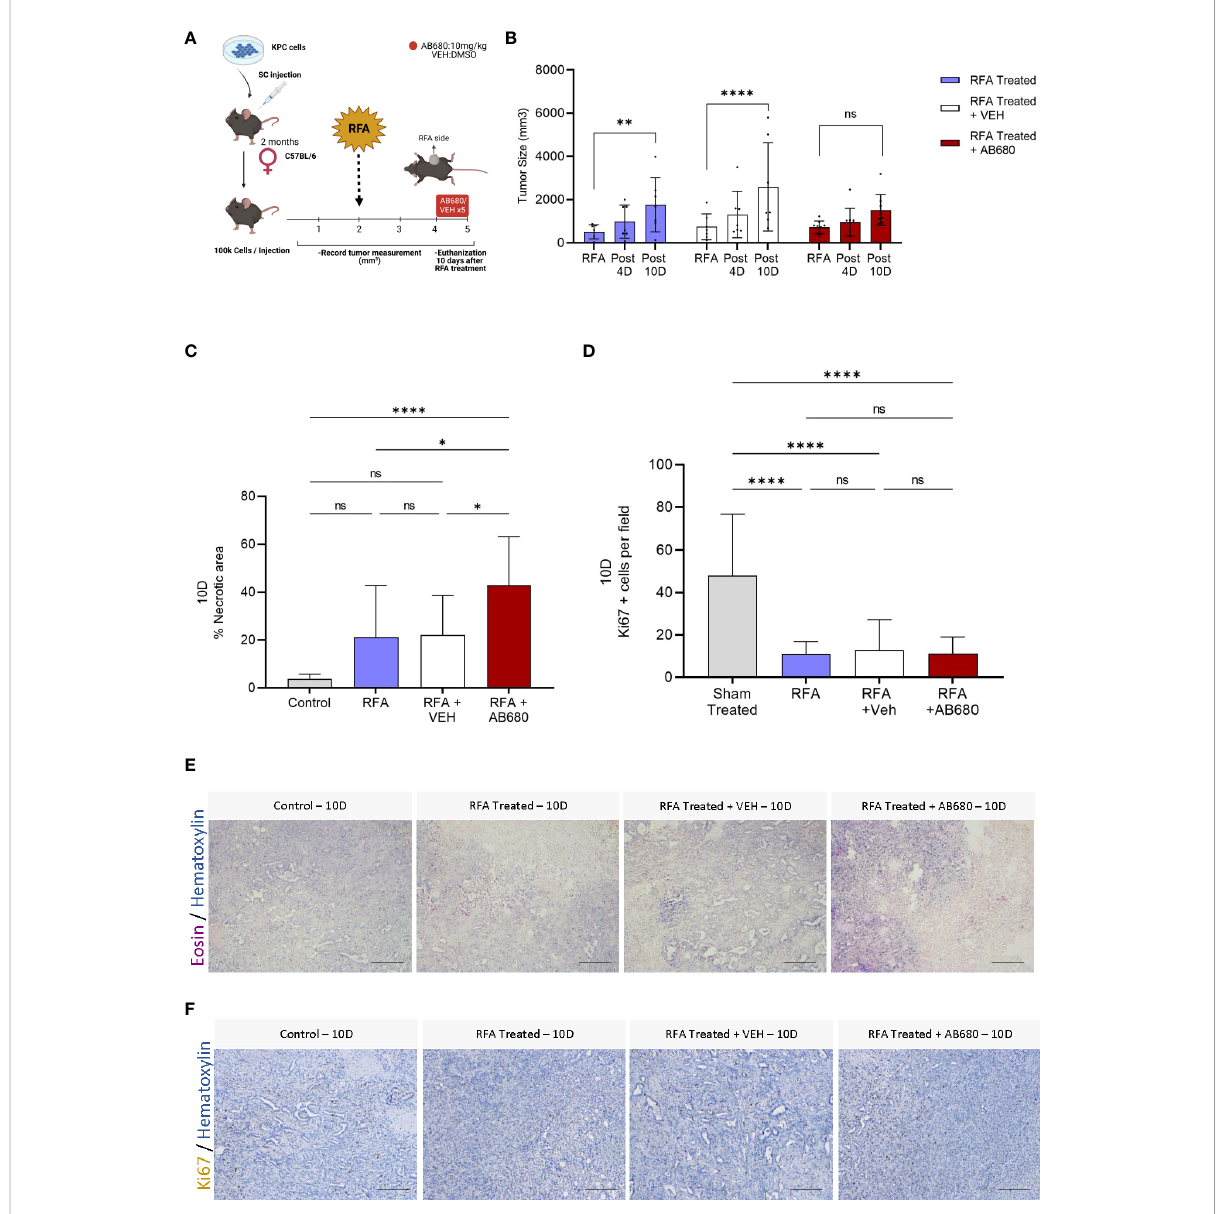
FIGURE 2 Inhibition of RFA-induced ADO generation in vivo prevented tumor enlargement and increased necrosis and anti-tumor immunity. (A) Experimental design of AB680 (CD73 inhibitor) in vivo treatment. (B) AB680 treatment promoted sustained RFA response by restraining tumor growth for up to 10 days after ablation (Post 10D, p = ns; n = 9), as evidenced by no signi fi cant increase in tumor size when compared to measurement immediately before RFA treatment (RFA). Contrarily, RFA only (p < 0.01; n = 7) and RFA + Vehicle (p < 0.0001; n = 7) treated tumors presented a signi fi cant increase in tumor size 10 days after treatment (Post 10) when compared to initial measurements (RFA). (C) Histological analysis of H&E staining (E) from RFA treated tumors 10 days after ablation revealed a signi fi cant increase in necrosis when RFA was used in combination with AB680 compared to KPC control tumors subcutaneously grown up to 10 days (p < 0.0001), RFA (p < 0.05 and RFA +VEH (p < 0.05) treated mice. D, Analysis of Ki67 positive cells by IHC staining (F) . RFA treated tumors 10 days after ablation revealed decreased Ki67 positive cells when compared to KPC control tumors subcutaneously grown up to 10 days (p < 0.0001), with no difference in between groups. Two-way ANOVA (B) and one-way ANOVA (C, D) were used for group comparisons. Bars represent 50uM, images were taken at